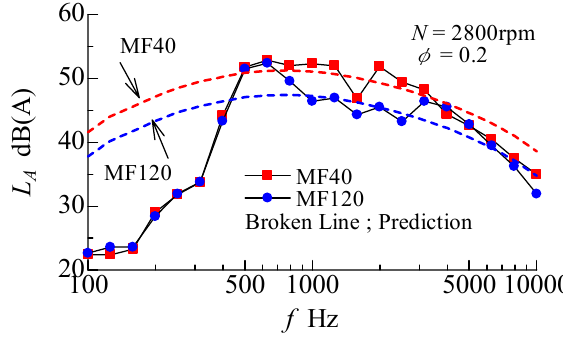
Fig.16 Spectrum distribution of the fan